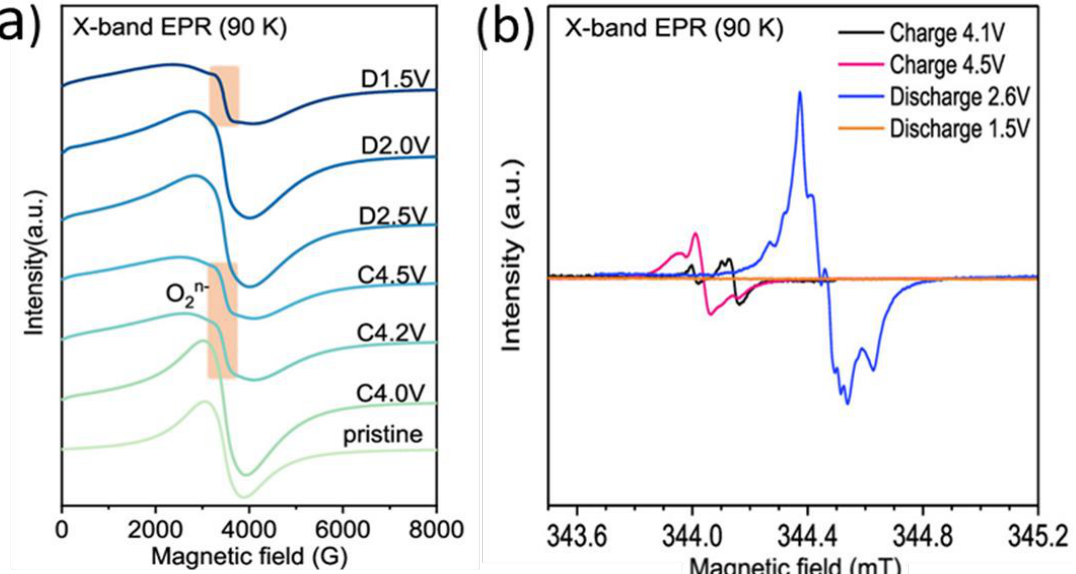
Figure 2. ( a ) EPR measurements of F-substituted Na 0.65 Li 0.22 Mn 0.78 O 1.99 F 0.01 at different charge-discharge states in the first cycle at 90 K. The pristine NLMOF exhibits only spectral lines representing antiferromagnetically coupled of Mn 4+ (t 2g 3 e g 0 , S = 3/2). When charged to 4.2 V, a signal of oxidized oxygen species O n − (n = 1, 2, 3) appears, indicating that the oxygen in the material is oxidized. 2 Meanwhile the line-shape of the Mn 4+ EPR signal becomes wider. At the end of charging, the line- shape of Mn 4+ is further broadened. The appearance of this phenomenon may be caused by the stronger electron-electron dipole interaction between Mn 4+ and O n − . During the discharge process, 2 the spectral line of Mn 4+ returned to its original state, and the signal of O n − seemed to disappear 2 between 2.5 and 2.0 V. At this time, O n − was successfully reduced. Additionally, because of the strong 2 electron-electron dipole interaction of Mn 3+ , the EPR spectral line is wider from 2.0 to 1.5 V. It is worth noting that the O n − signal at 1.5 V originates from carbonate species generated during discharge. 2 Panel ( a ) is reproduced with permission from ref. [40]. Copyright 2021, copyright American Chemical Society. ( b ) Similar EPR measurements were performed on unsubstituted Na 0.72 Li 0.24 Mn 0.76 O 2 in the region where the oxygen resonance peak appears. The hyperfine structure of the EPR signal of O n − 2 is shown here. Panel ( b ) is reproduced with permission from ref. [35]. Copyright 2020, copyright American Chemical